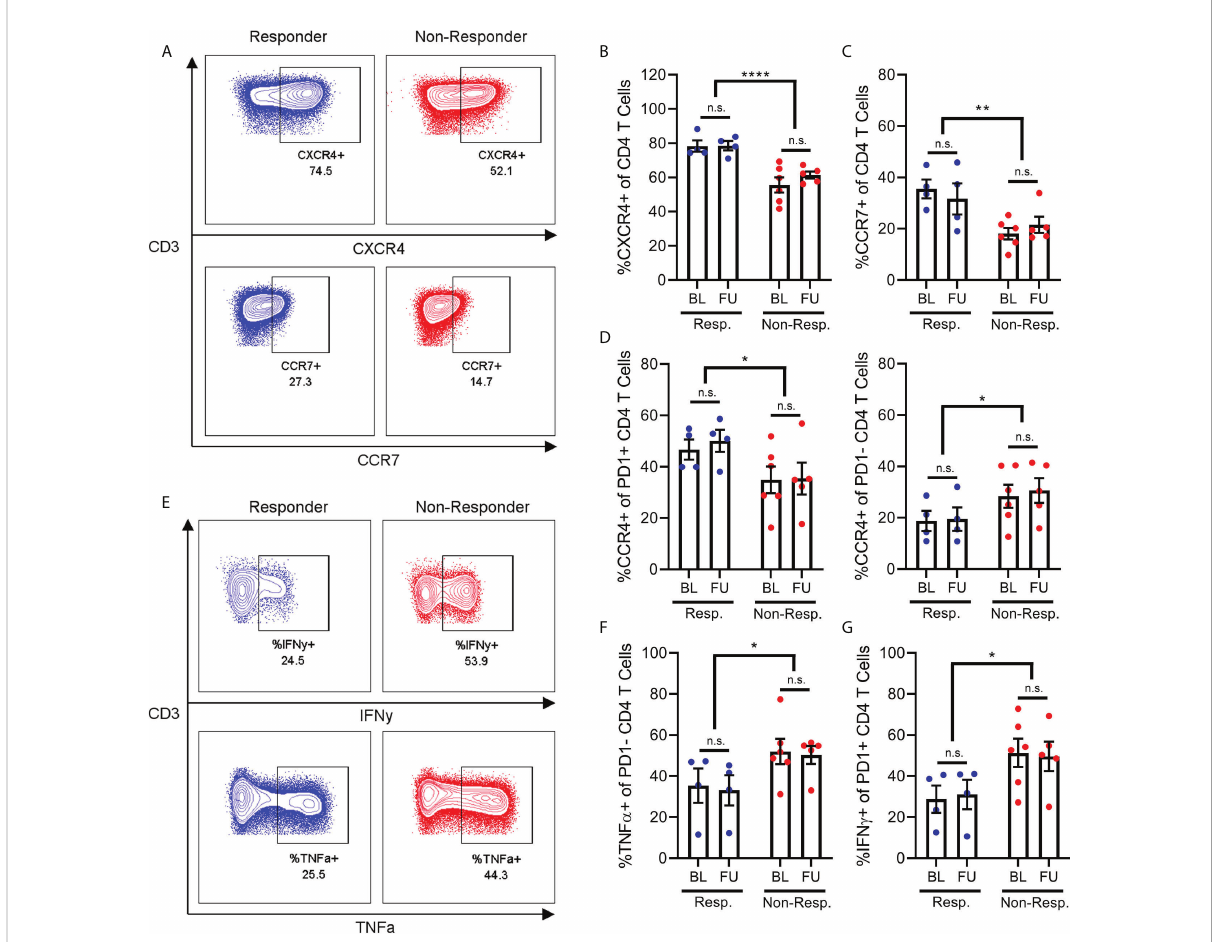
FIGURE 3 Chemokine receptor and cytokine expression on CD4+ T-cells. Frequency of CD4+ T cells (A) expressing CXCR4 (B) or CCR7 (C) are reduced in non-responder patients compared to responders. Frequency of PD1+ T cells expressing CCR4 is decreased in non-responder patients, while frequency of PD1- T cells expressing CCR4 is increased in non-responders (D) . Frequency of PD1- CD4 T cells ( E , top) expressing IFNy (F) , or frequency of PD1- CD4 T cells (E, bottom) expressing TNFa (G) are both increased in non-responder patients. N.S, not signi fi cant; *p<0.05; **p<0.01